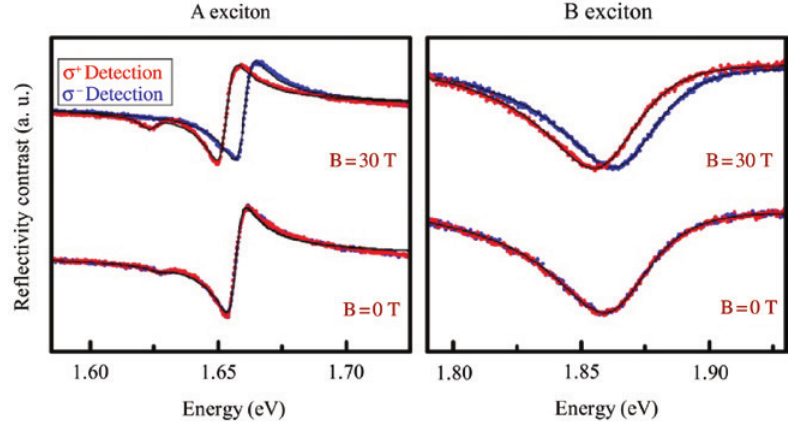
monolayer, measured at low temperature 2